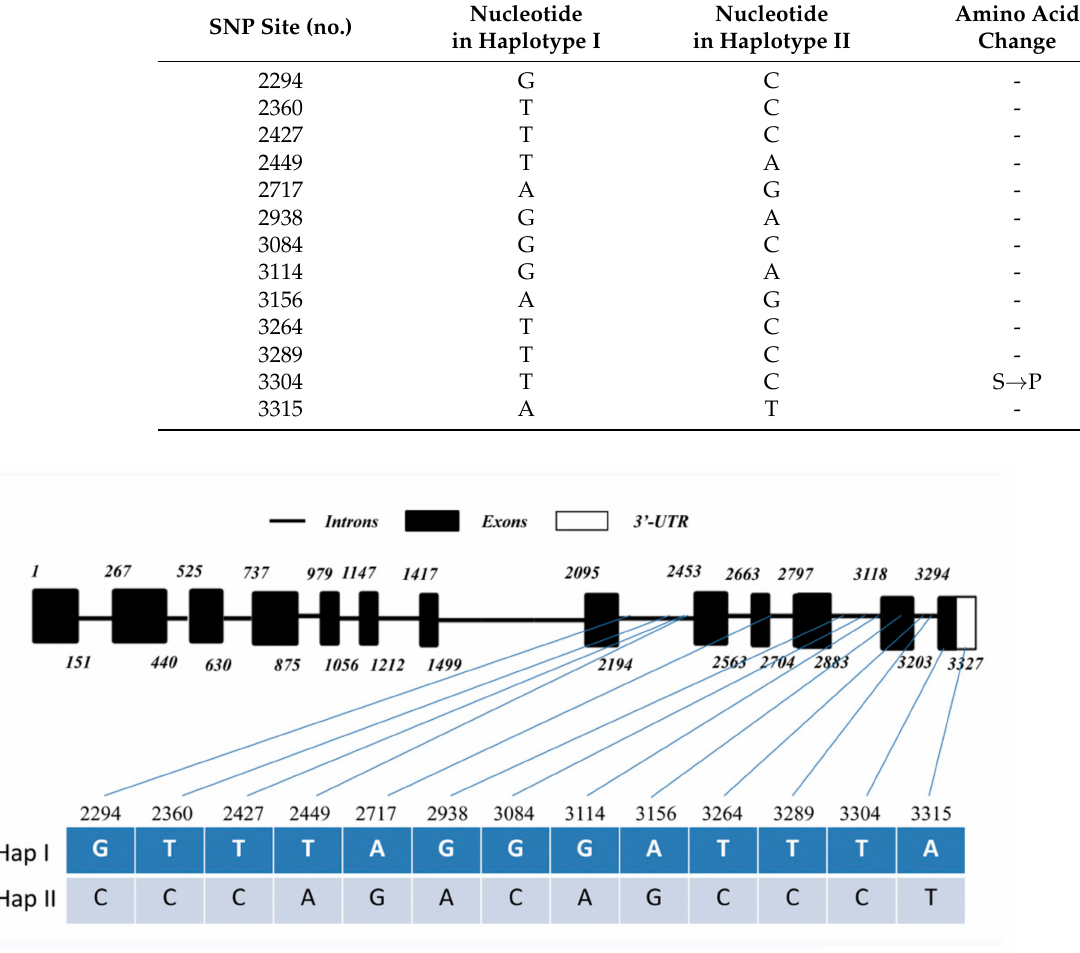
Figure 1. Genomic structure of the TaAACT1 gene. Black squares indicate exons. Variations in the genomic sequence of TaAACT1 in the test wheat cultivars could be divided into two haplotypes (Hap I and Hap II). The number indicates the nucleotide